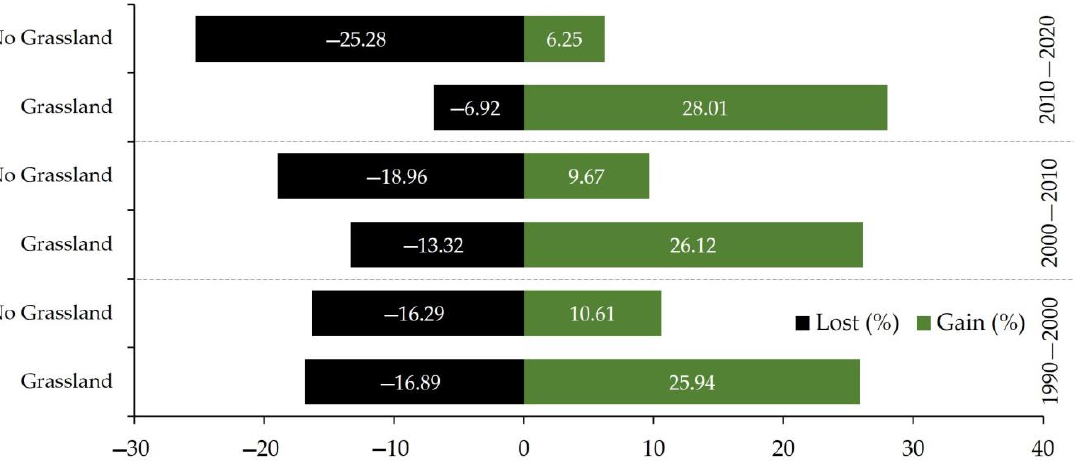
Figure 8. Gains and losses in hectares of grassland and non-grassland for each of the periods of analysis in the Pomacochas micro-watershed.